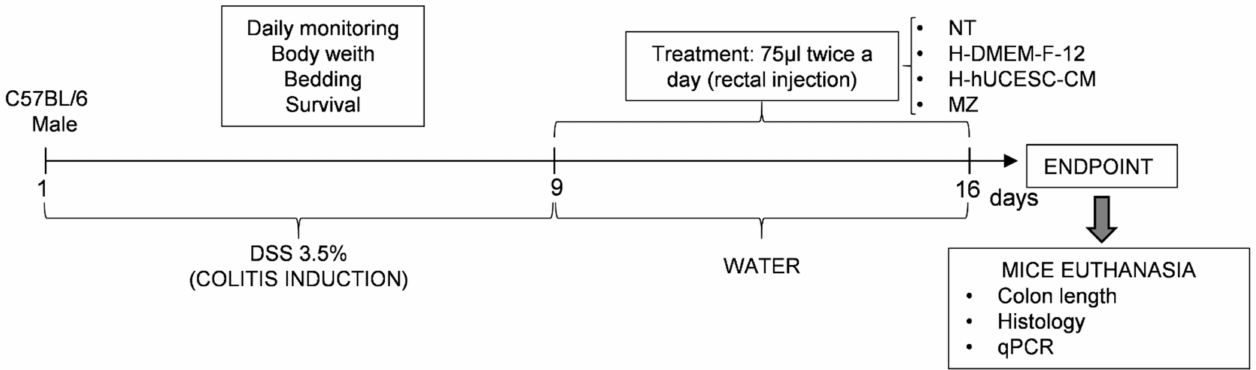
Figure 1. Study design for DSS induced colitis. Acute colitis was induced in C57BL/6 mice by administering 3.5% dextran sulfate sodium (DSS) in drinking water for nine days. Between 10 and 15 days, 75 µ L of each treatment was rectally administered twice daily using a 26-gauge probe needle. On day 16 animals were sacrificed. NT: non treated, H-DMEM-F- 12: DMEM-F12-loaded hydrogel; H-hUCESC-CM: H-hUCESC-CM-loaded hydrogel; MZ: